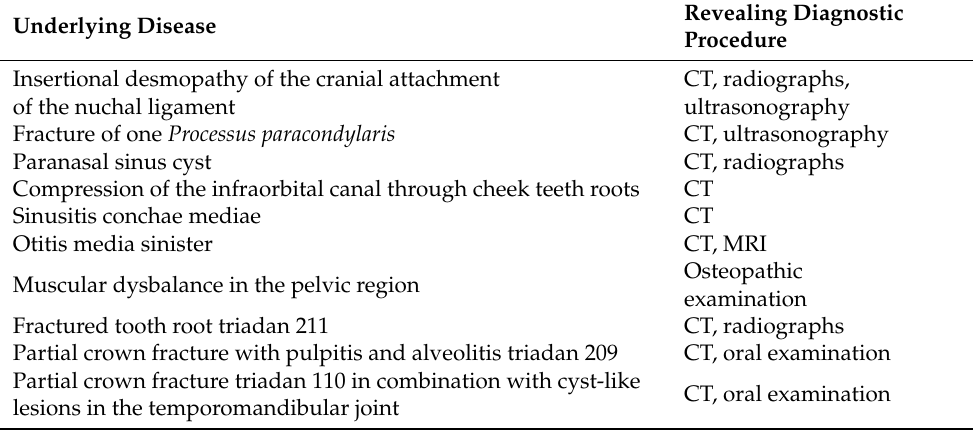
Table 5. Underlying pathologic diseases with proven causality of horses diagnosed with s-HS and the diagnostic procedures revealing the finding. CT: computed tomography, MRI: magnetic resonance